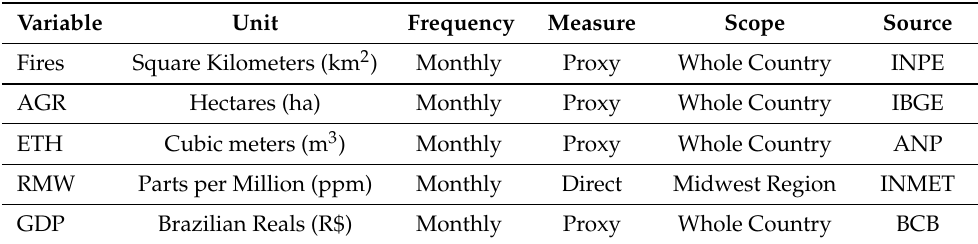
Table 1. Description of key variables and their